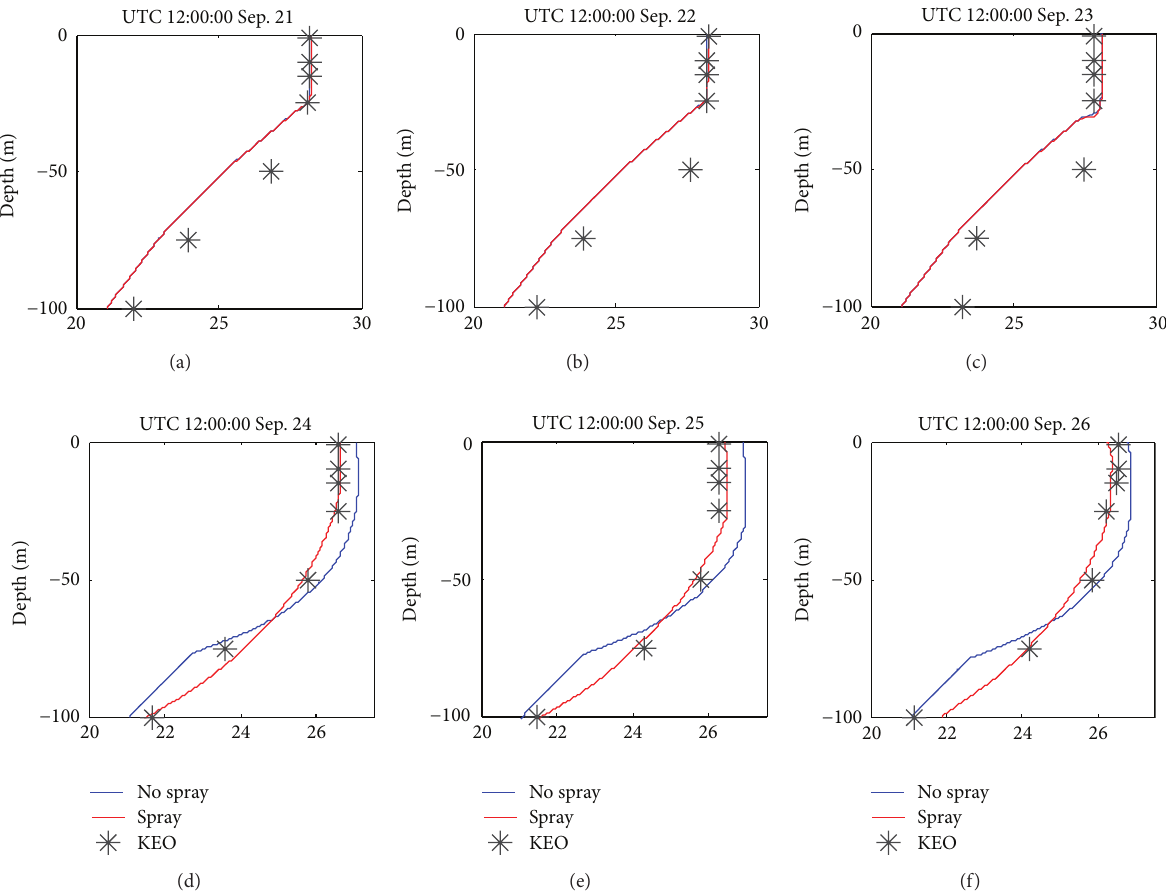
Figure 7: Upper 100m temperature profiles simulated by Test 1 (no spray, blue curves) and Test 2 (spray, red curves) at ((a)–(f)) 12:00 September 21–26, 2006. Gray asterisks indicate the KEO observed